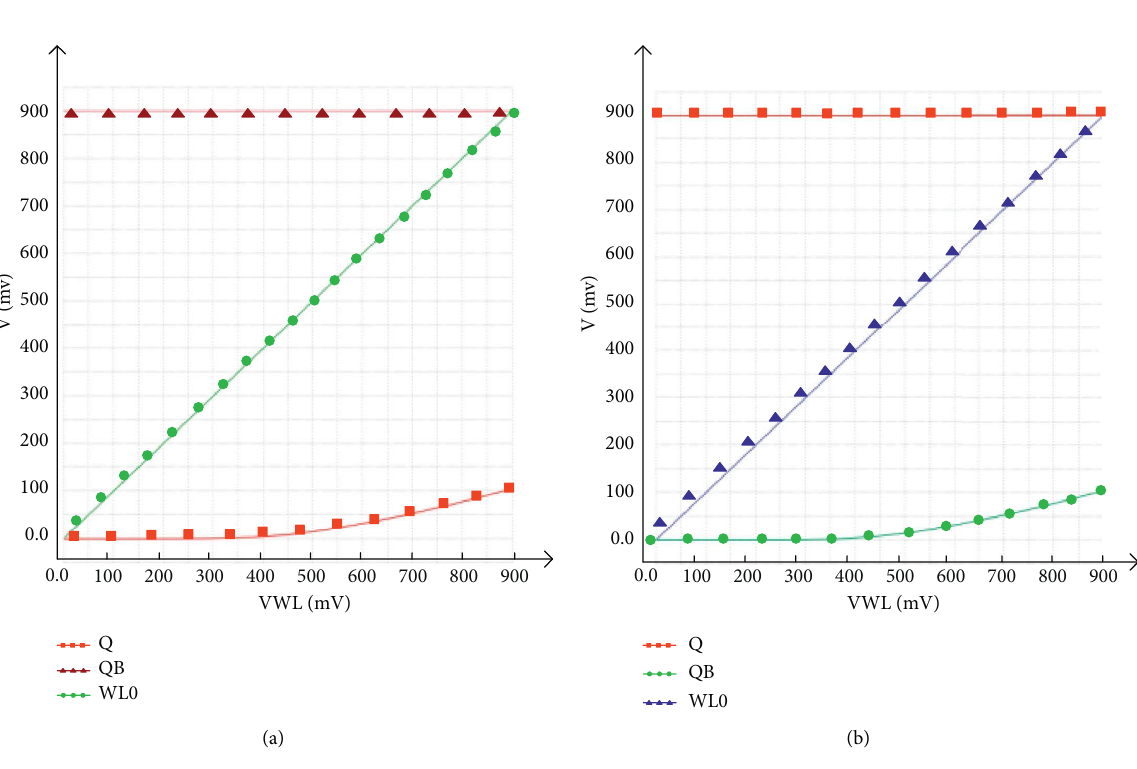
Figure 11: (a) Read 0 operation; (b) read 1